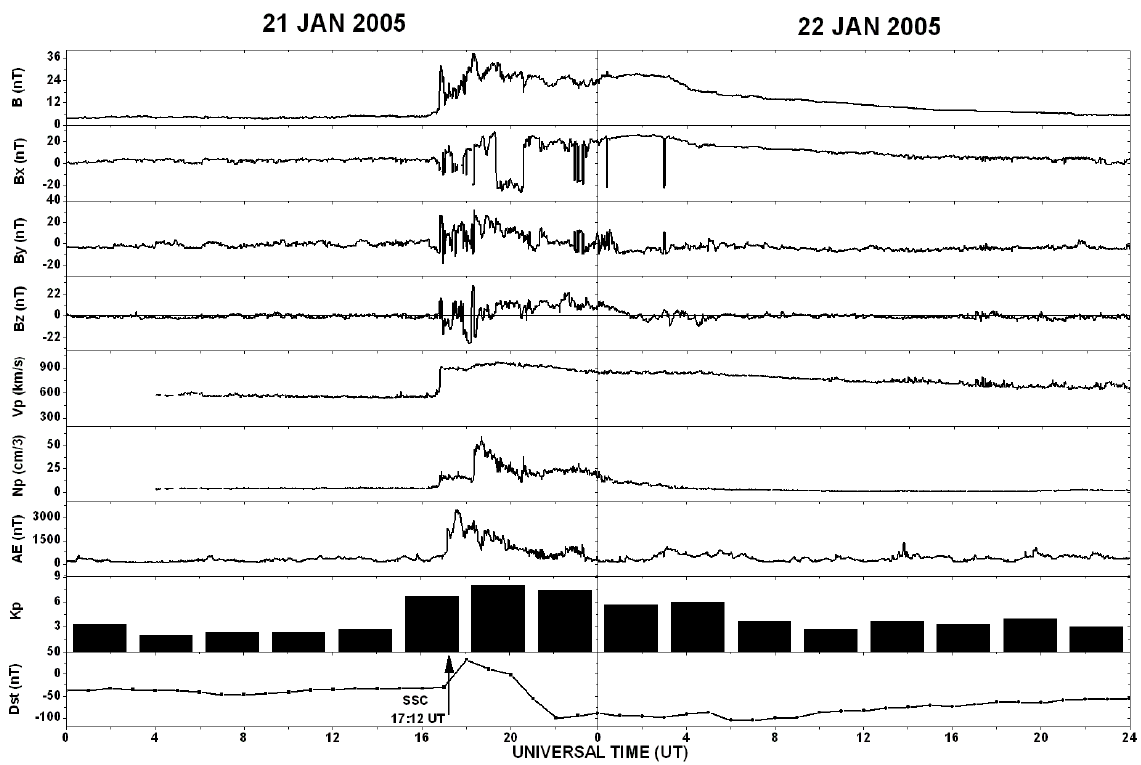
Fig. 2. Variations of geomagnetic indices (Kp, AE, and Dst), solar wind (number density and velocity), and interplanetary magnetic field Figure 2 680 (IMF) (total ( B ) and three components viz., B x , B y , and B z ) observed on 21 and 22 January 2005. The solar wind and IMF data were obtained from the ACE satellite site